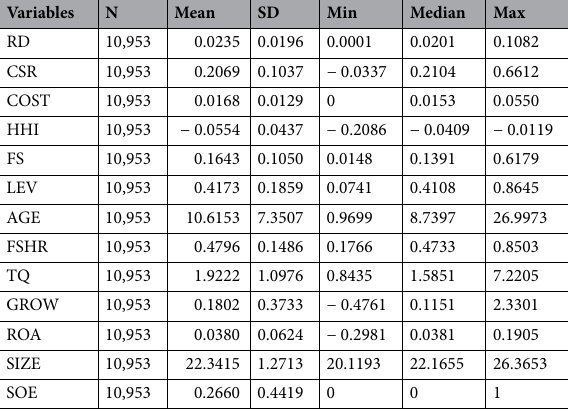
Table 2. Descriptive statistics of